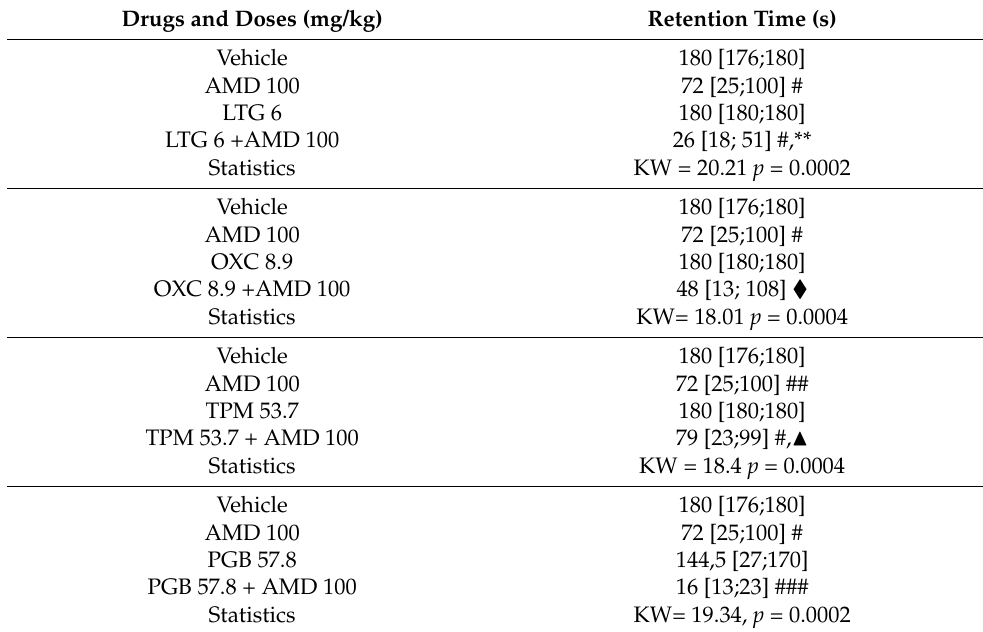
Table 2. Effects of acute amiodarone, antiepileptic drugs, and their combinations on long-term memory in mice. Drugs and Doses